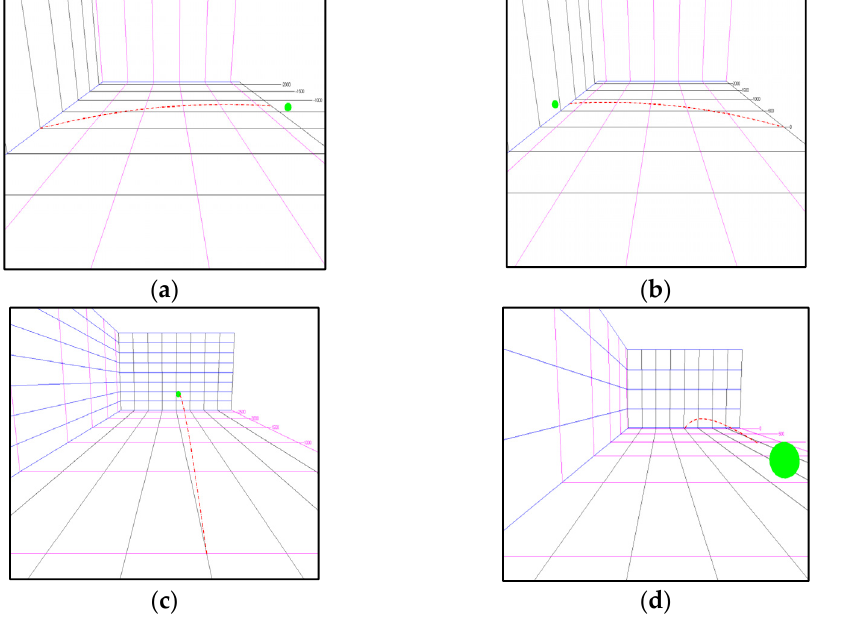
Figure 3. Last frame of trajectory (along with previous trajectory trace) when captured through four different simulated cameras. ( a ) One side camera view. ( b ) Other side camera view. ( c ) Throwing side camera view. ( d ) Catching side camera view.